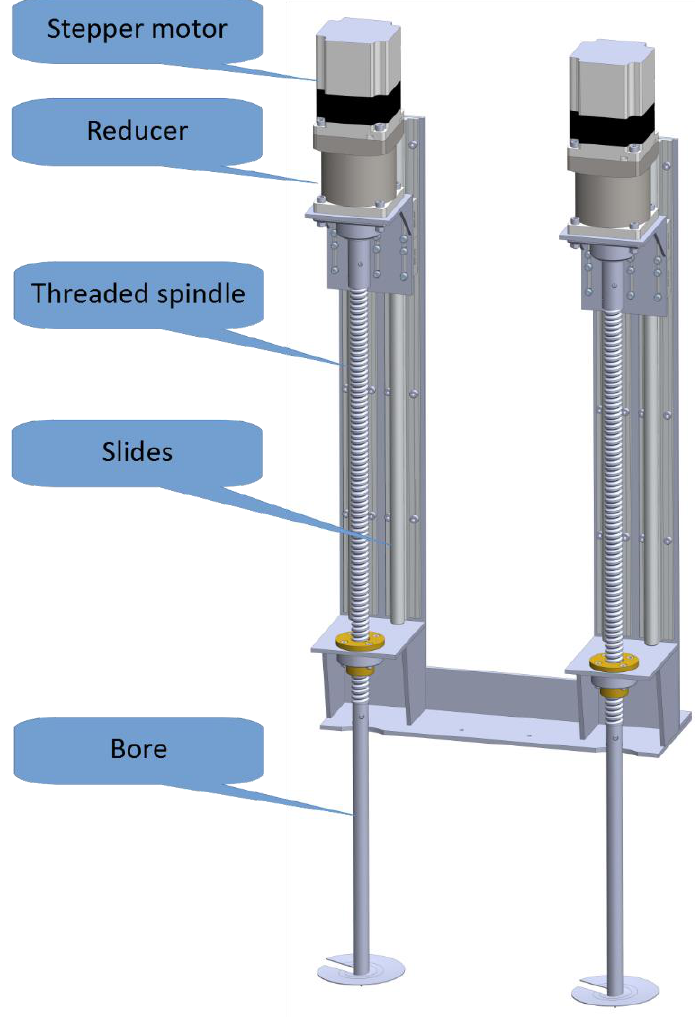
Figure 5. Model of the anchoring module.